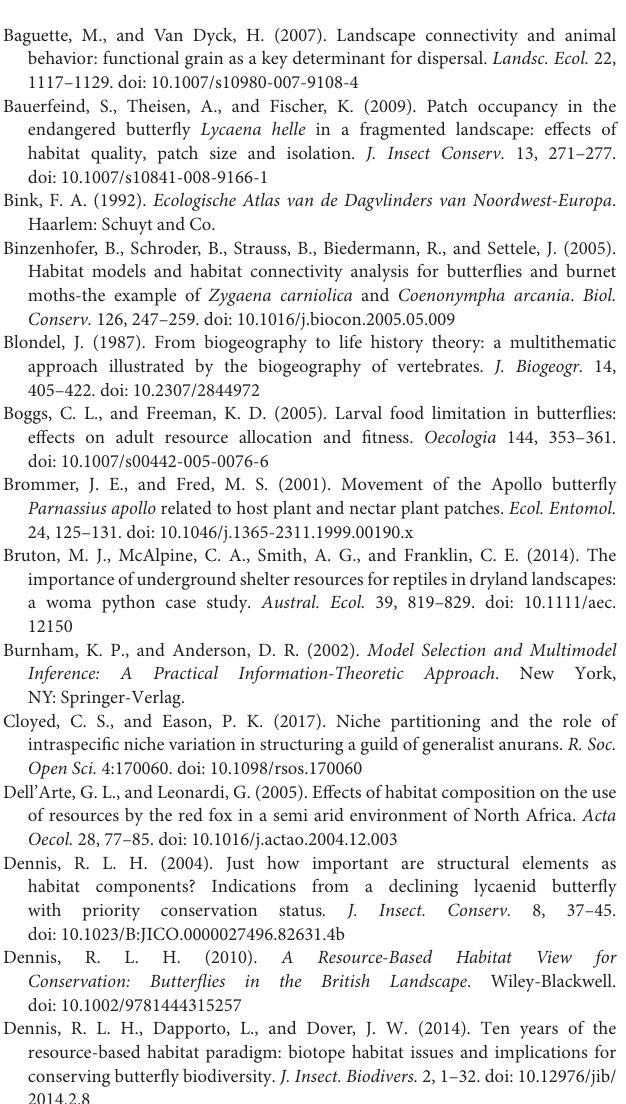
Supplementary Figure 1 | Summary table on how vegetation type, vegetation composition and ecological resources were assessed in this study. (A) A vegetation type was assigned to each zone of the Pisserotte reserve and each site hosting a population of B. eunomia and B. aquilonaris . (B) Vegetation composition was summarized separately by the two first axes of Principal Component Analysis (PCAs) using vegetation samples collected in Pisserotte (400 samples summarized in PIS-1 and PIS-2 ), in B. eunomia populations (247 samples summarized in BEU-1 and BEU-2 ) and B. aquilonaris populations (759 sites summarized in BAQ-1 and BAQ-2 ). (C) Ecological resources measured from vegetation samples and extra measurements in each zones and sites. As some